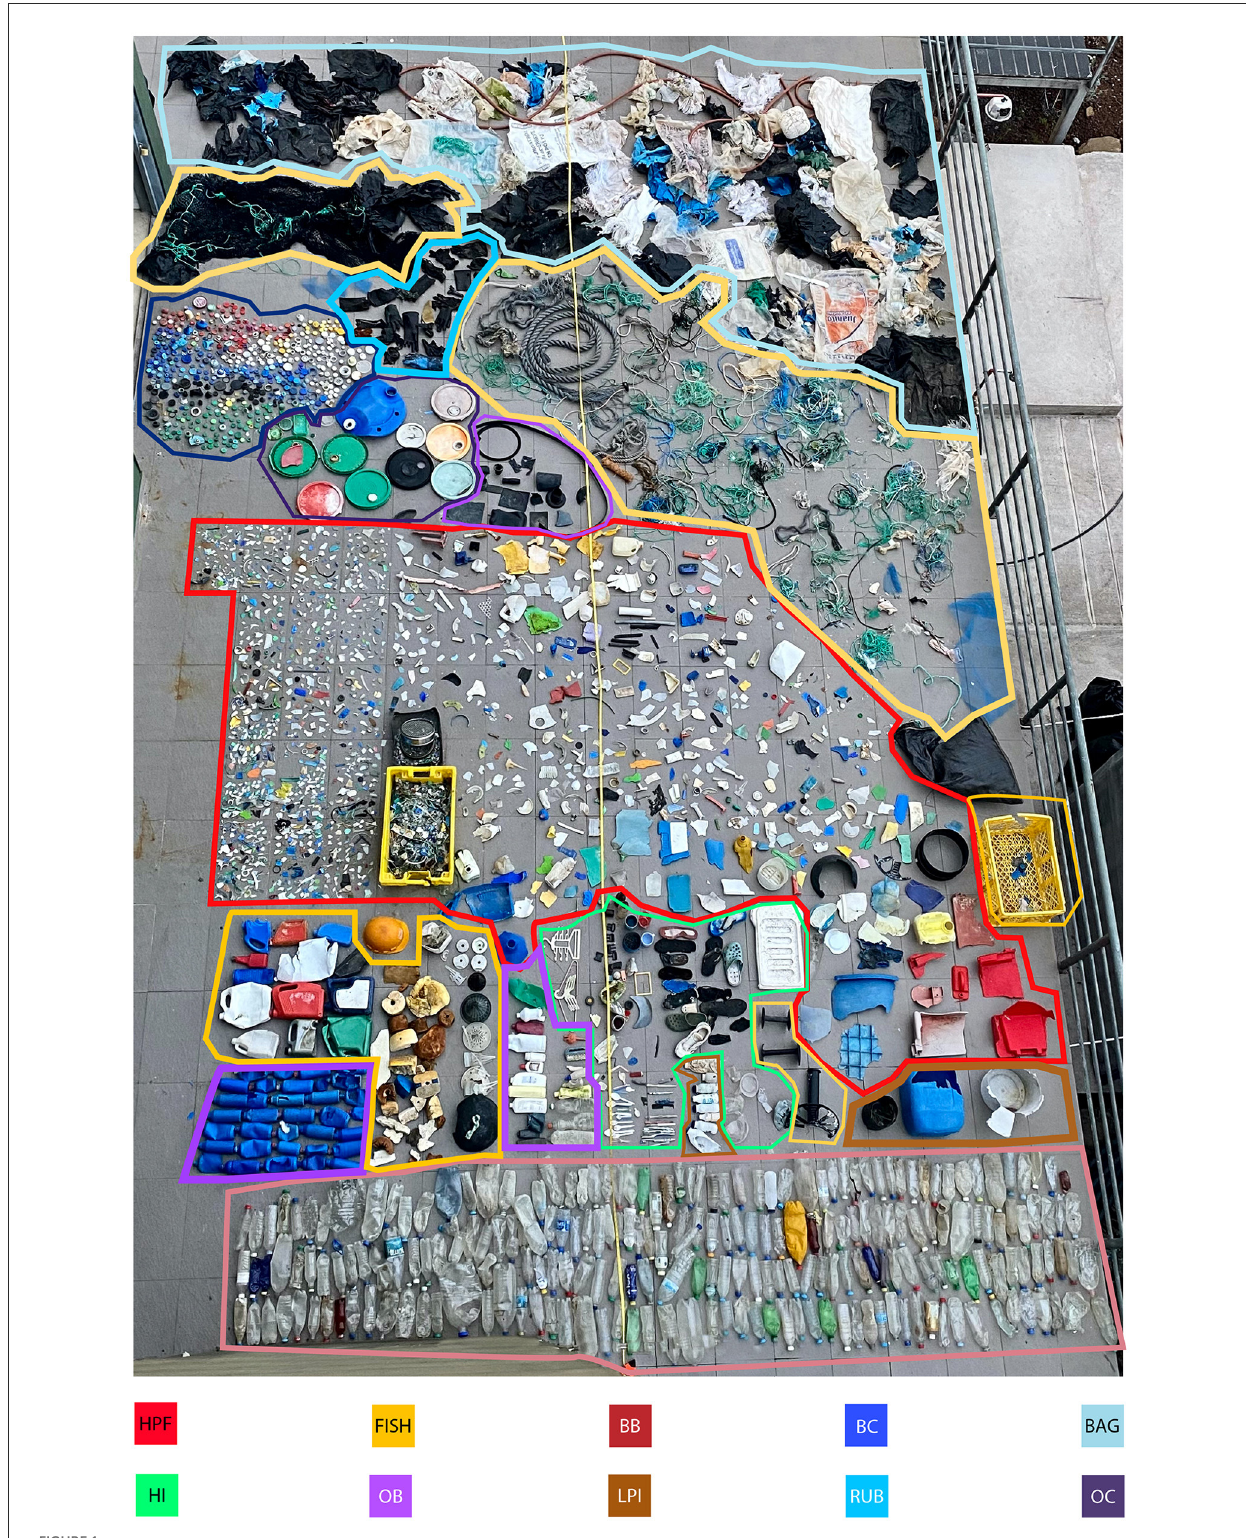
FIGURE1 Macroplastic categorization process. CSIRO categorization system (Schuyler et al., 2020) with adaptations. Categories are: HPF (Hard plastic fragments); FISH (Engine oil bottles, fishing buoys, fishing nets, monofilament fishing line, eel traps, plastic rope, string, twine); BB (Plastic beverage bottles); BC (Beverage bottle caps); BAG (Plastic bags); HI (Household items, razors, toothbrushes, deodorants, toys, straws, popsicle sticks, utensils, cutlery, food containers, tetra pack, plastic cups, plastic packing straps, shoes, sandals, balloon, cigarette, cloth item); FP (Film plastic food wrap, chip bags, “other” soft plastic); OB (Other bottles, i.e., shampoo, kitchen oil); LPI (Large plastic items, i.e., buckets, boxes, tubes); FOAM (Any foam); RUB (Rubber gloves or other rubber items, i.e., tires.); OC (Other caps/lids); OTHER (Other items, i.e., glass, metal, paper). The measuring tape was 10m in length. This figure shows a macroplastic density of 2.10 items/m 2 from the windward remote San Cristóbal Island in El Pescador (LAT-0.917083 ◦ ; LONG − 89.404444 ◦